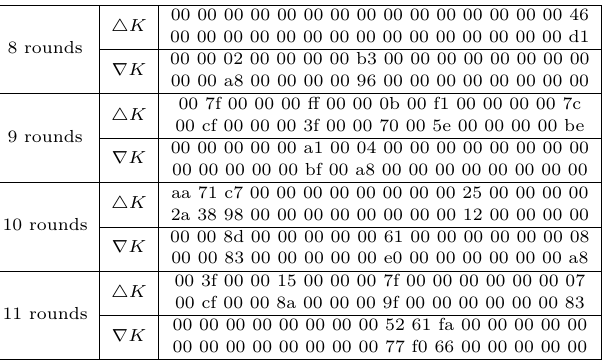
Table 5: Master tweakey differences for distinguishers of Deoxys-BC-256